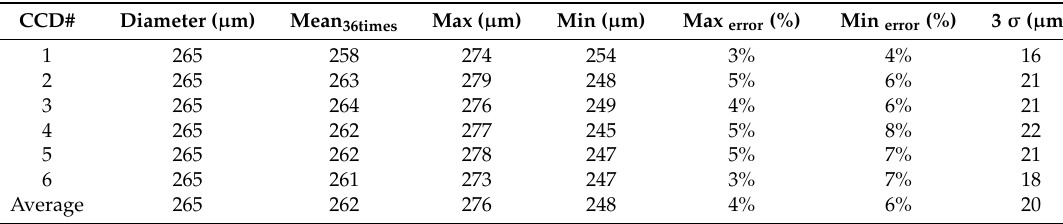
Table 5. Results for Detected Protrusion on Blue